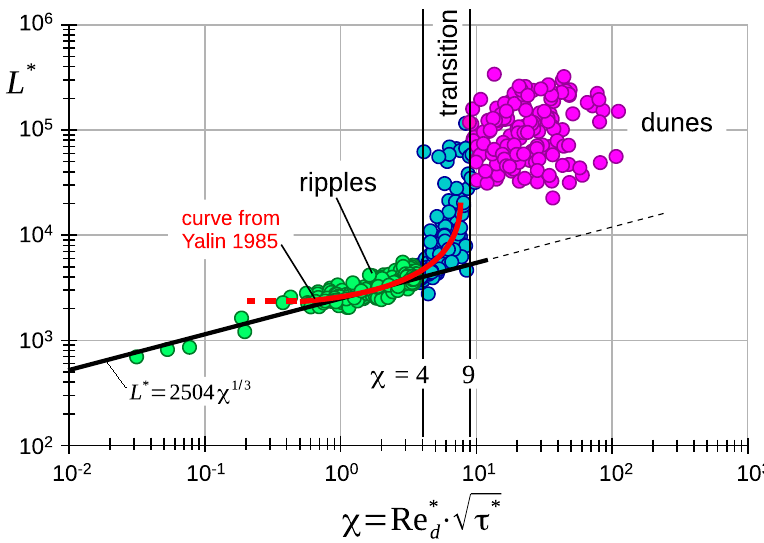
Figure 4. Bed forms and ripple lengths as result of a data evaluation after Lapotre et al., 2017. Green: ripples, magenta: dunes, blue addressed as an intermediate stage. The red line shows the mean course of the data from Yalin 1985 (Figure